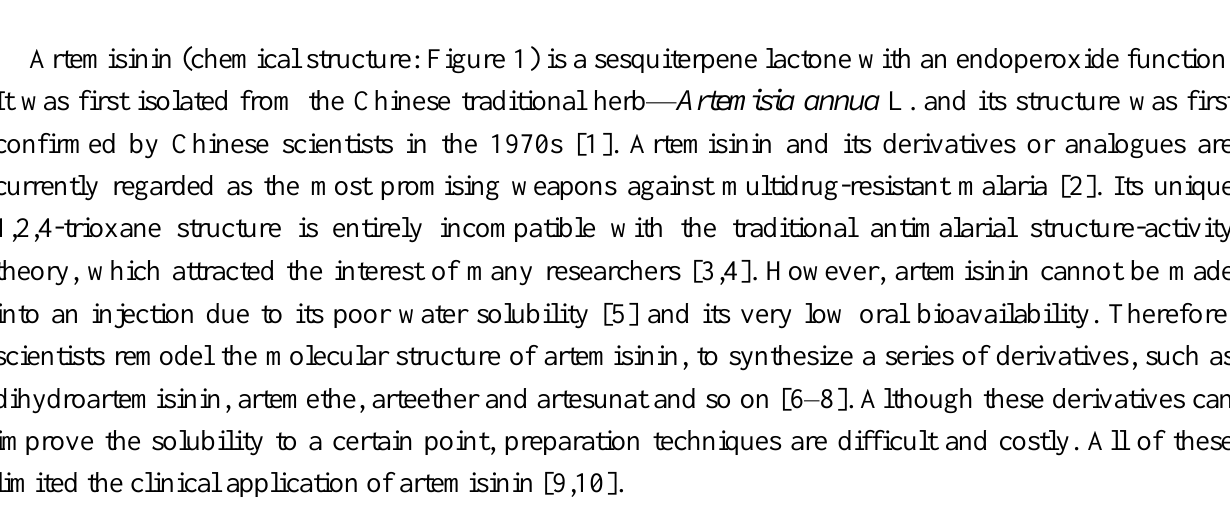
Figure 1. The chemical structure of artemisinin (the molecular weight is